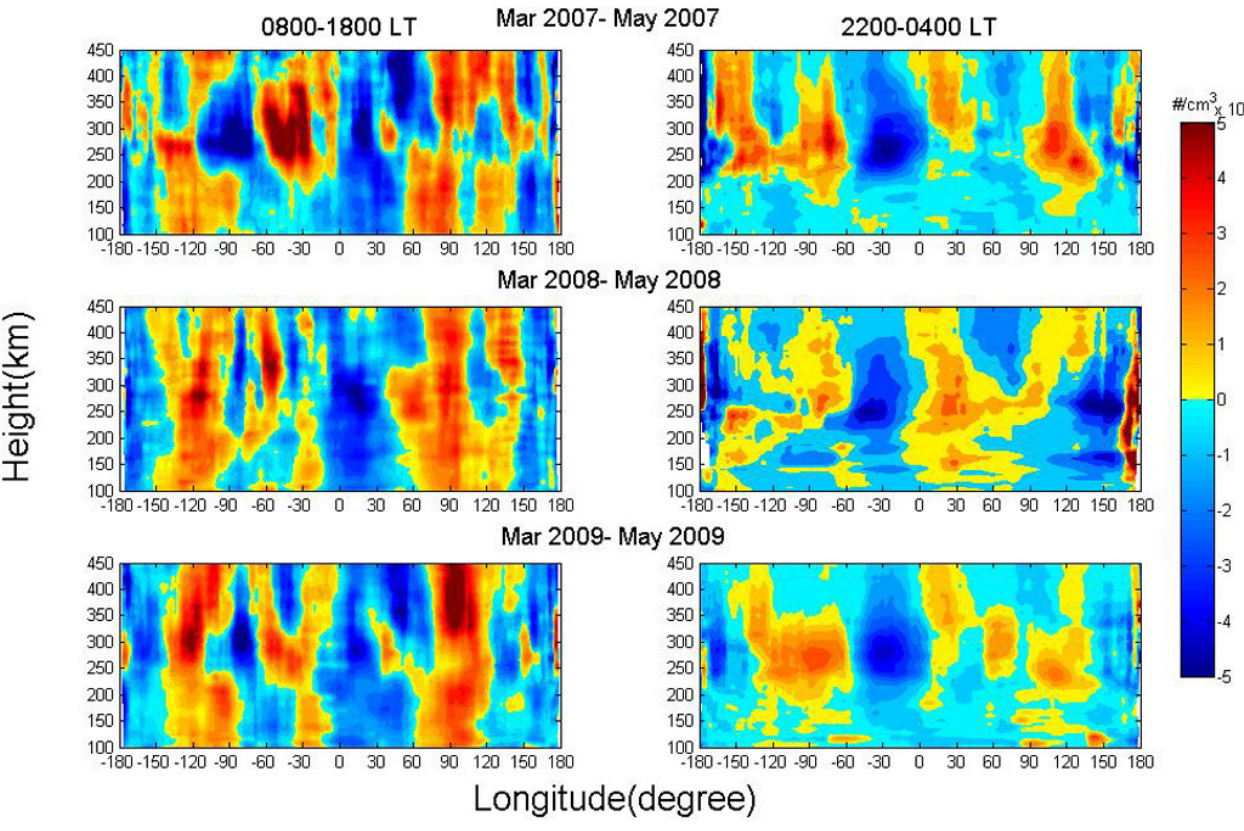
Fig. 4. Same as Fig. 2 but for March equinox in 2007, 2008 and